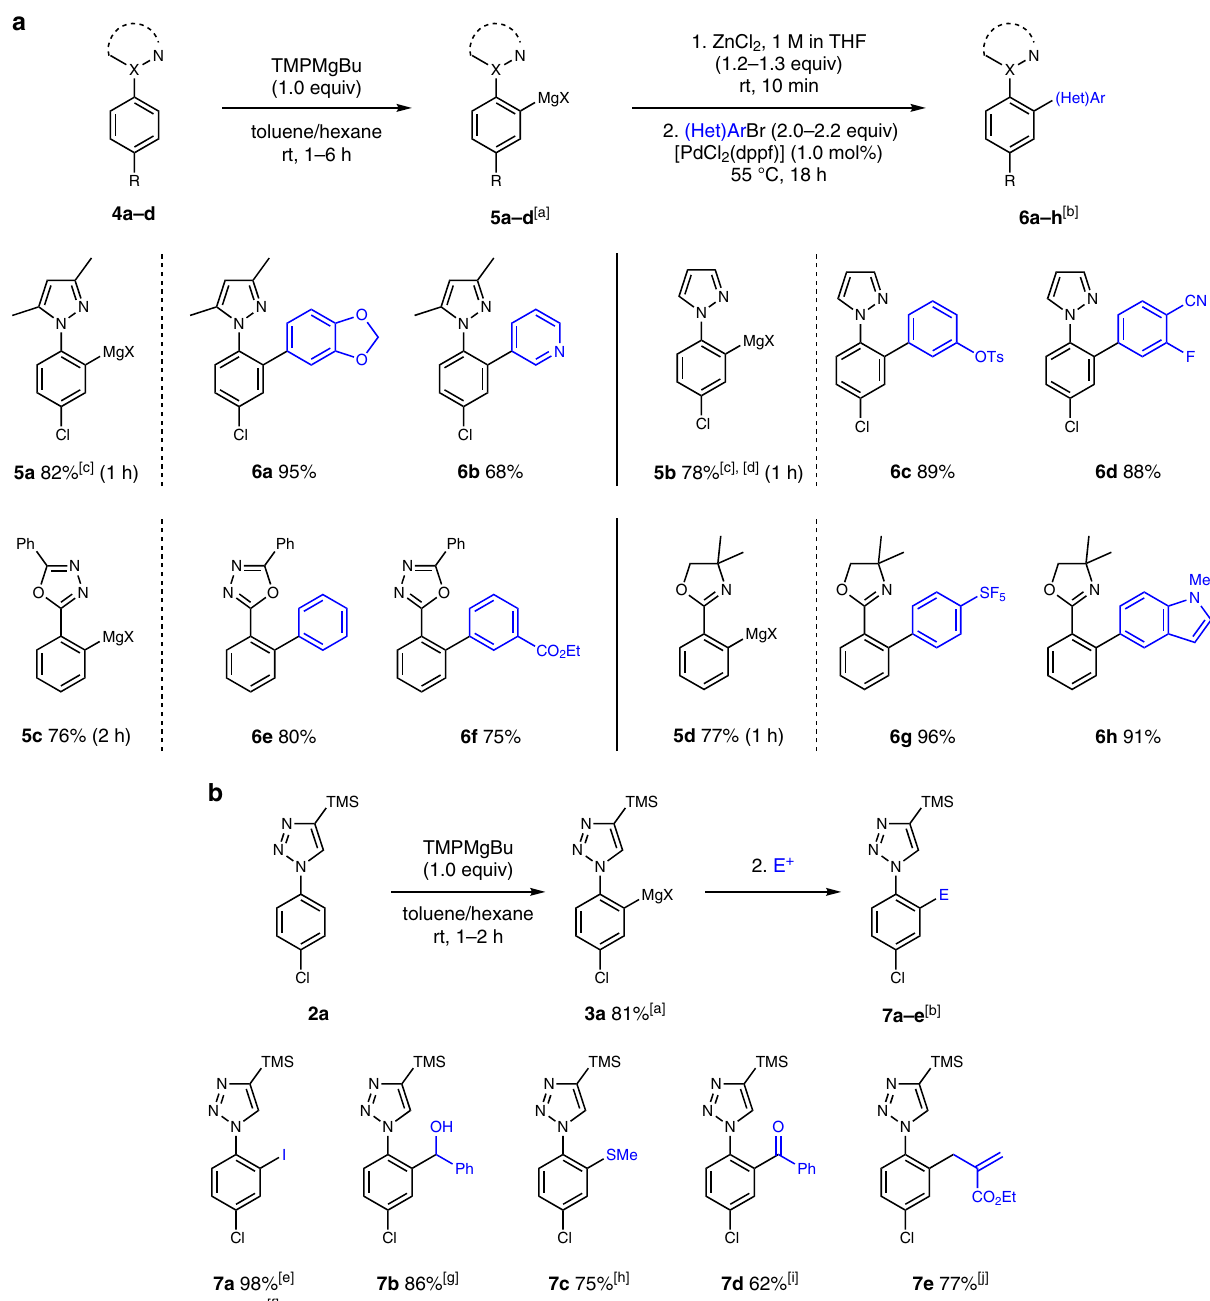
Fig. 4 Substrate scope of aryl azoles and electrophiles. a Metalation of various aryl triazole derivatives and scope of the subsequent palladium-catalyzed cross-coupling. [a] Metalation yields were determined by 1 H-NMR analysis of D 2 O-quenched reaction aliquots. Metalation time in brackets. [b] All yields refer to isolated compounds. [c] No metalation at the heterocycle was observed. [d] Performing the reaction with TMPLi exclusively led to metalation of the azole moiety. b Trapping of magnesium reagent 3a with various electrophiles. [e] I 2 (4.3 equiv). [f] Metalation of 2a with Bu 2 Mg (vide infra), then I 2 (4.3 equiv). [g] Benzaldehyde (2.5 equiv). [h] MeSSO 2 Me (2.5 equiv). [i] Transmetalation with CuCN • 2LiCl (3.0 equiv), then benzoyl chloride (2.5 equiv).